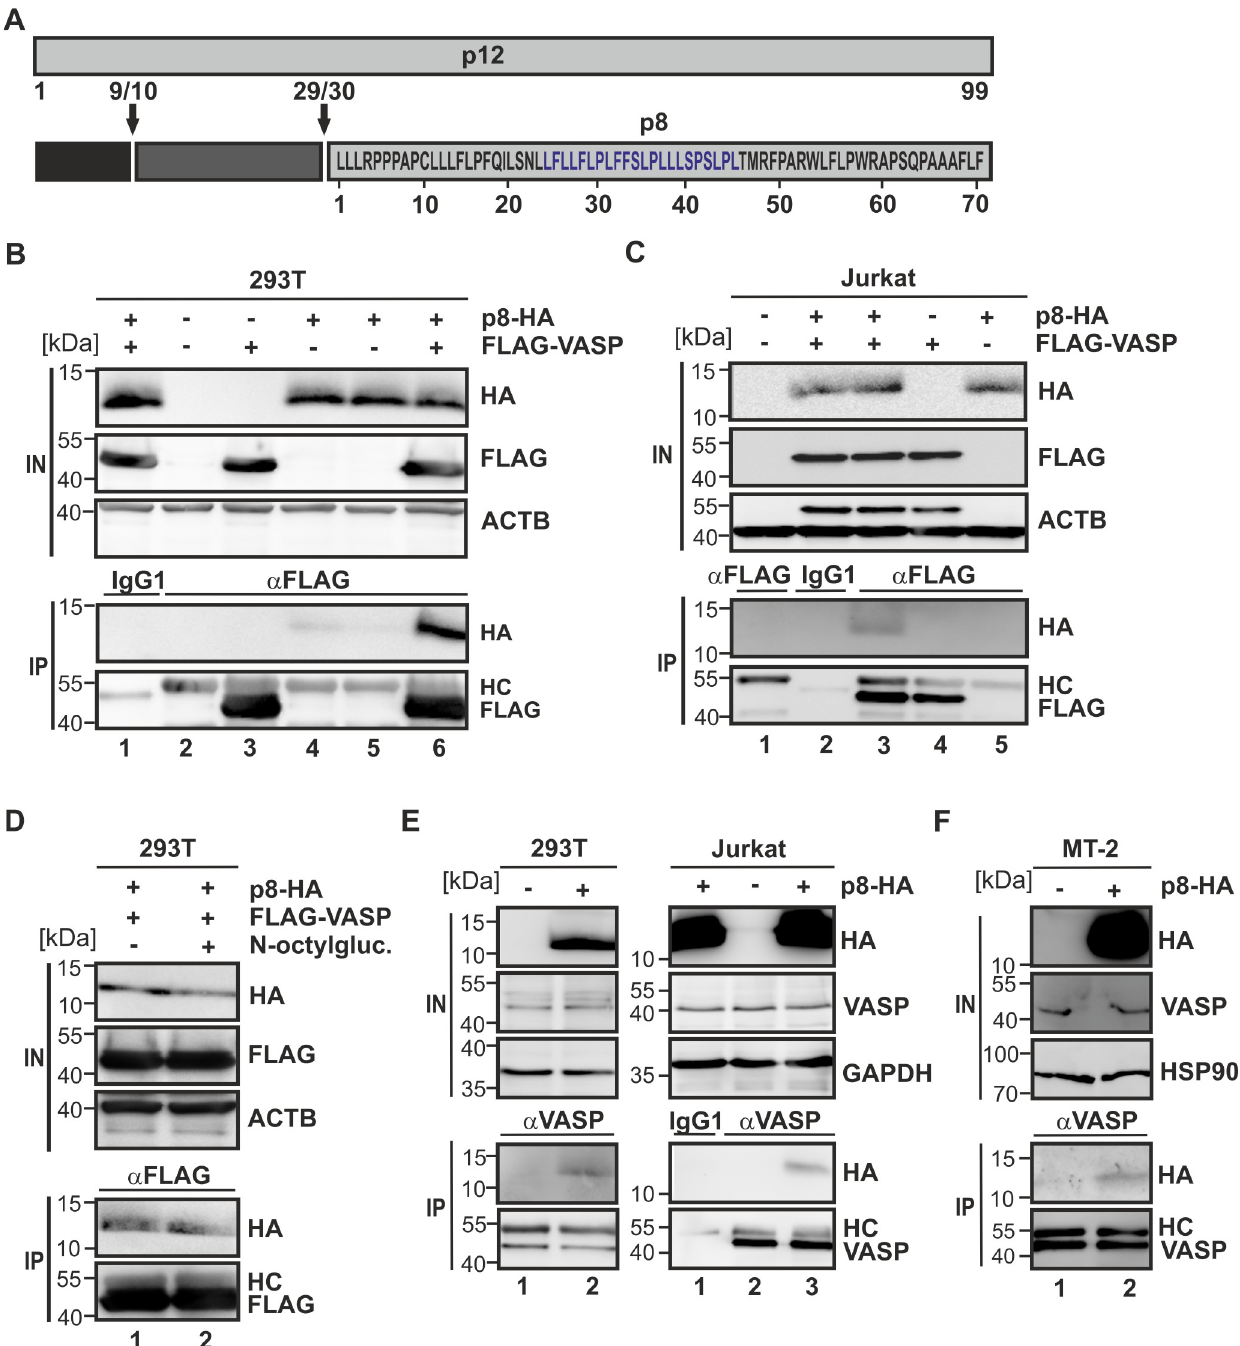
Fig 1. VASP is a novel interaction partner of p8. (A) Scheme of the HTLV-1 p8 protein and its precursor p12. A motif mediating potential interactions with the VASP EVH1 domain is highlighted in blue. (B) 293T cells or (C) Jurkat T-cells were transfected with expression plasmids p8-HA and FLAG-VASP or empty control vectors. After 48 h, cells were lysed and 10% of the lysates were taken as input (IN). Co-immunoprecipitations (IPs) were performed using anti-FLAG antibodies or isotype-matched control antibodies (IgG). Immunoblots are shown. HC, heavy chain. (D) 293T cells were transfected with expression plasmids p8-HA and FLAG-VASP. After 48 h, cells were lysed and 10% of the lysates were taken as input. Lysates were treated without (lane 1) or with 60 mM N-octyl- β -D-glucoside (N-ocytlgluc.; lane 2). IPs were performed using anti-FLAG antibodies. Immunoblots are shown. (E) 293T, Jurkat or (F) HTLV-1-infected MT-2 cells were transfected with expression plasmids p8-HA. After 48 h, cells were lysed and 10% of the lysates were taken as input. Endogenous VASP was precipitated using anti-VASP antibodies. Immunoblots are shown.